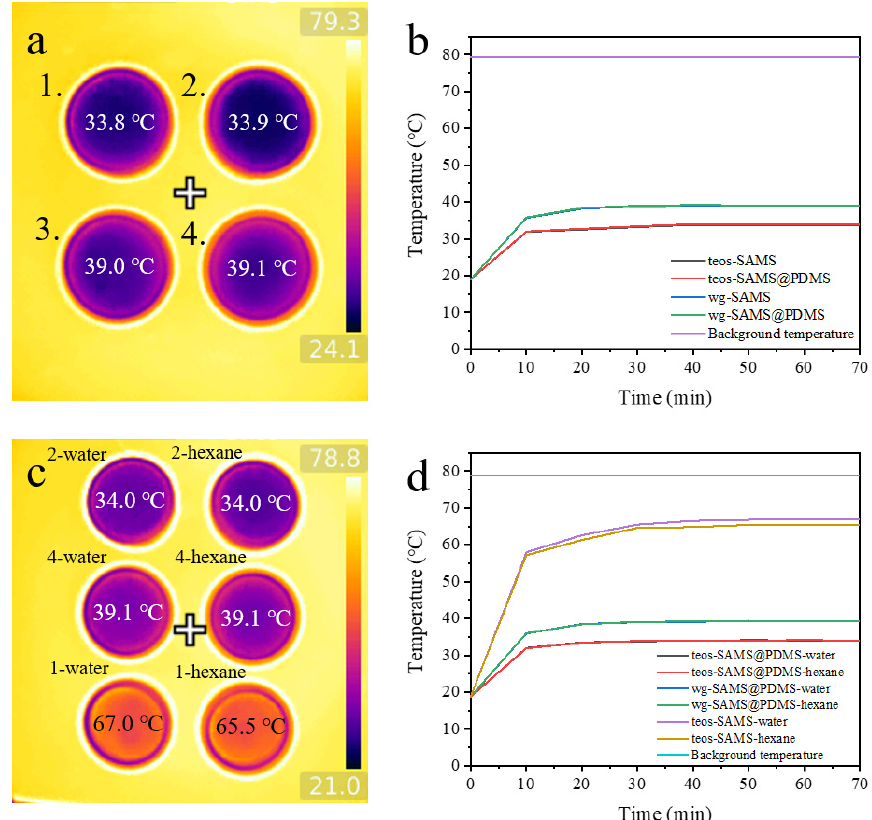
Figure 5. ( a ) Infrared images of the intact powders of teos-SAMS-4.5 (1), teos-SAMS-4.5@PDMS (2), wg-SAMS-4.5 (3), and wg-SAMS-4.5@PDMS (4) on the hot surface. ( b ) The surface temperature curve as a function of time for SAMS and SAMS@PDMS. ( c ) Infrared images of the solvent-treated powders of teos-SAMS-4.5 (1-water and 1-hexne), teos-SAMS-4.5@PDMS (2-water and 2-hexane), and wg-SAMS-4.5@PDMS (4-water and 4-hexane) on the hot surface. 1-water and 1-hexne: teos-SAMS-4.5 powder after immersion in water and in hexane for 5 days, respectively; 2-water and 2-hexne: teos-SAMS-4.5@PDMS powder after immersion in water and in hexane for 5 days, respectively; 4-water and 4-hexne: wg-SAMS-4.5@PDMS powder after immersion in water and in hexane for 5 days, respectively. During the thermal insulation test, the aerogel powders were put in glass petri dishes without lids, which were put on the hot face for 70 min before imaging. ( d ) Surface temperature curve as a function of time for solvent-treated SAMS and